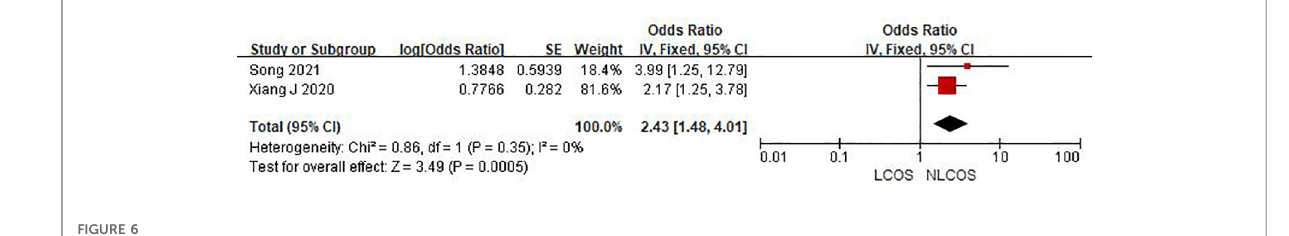
FIGURE 6 Biventricular shunt before operation forest plot.